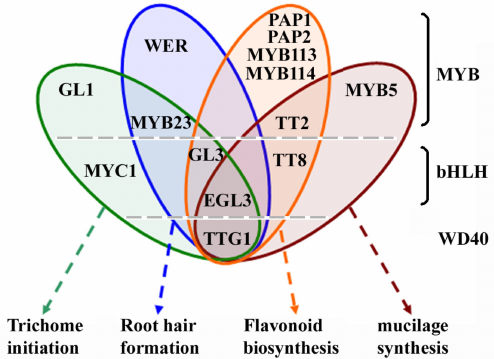
Figure 1. Components of the epidermal cell fate determination, flavonoid and mucilage biosynthesis regulating MBW activator complexes. Some of the components are presented in all the MBW activator complexes, some are not. The WD40-repeat protein TTG1, and the bHLH transcription factors EGL3 are involved in the regulation of epidermal cell fate determination, flavonoid and mucilage biosynthesis. The bHLH transcription factor MYC1 is involved in the regulation of trichome initiation. TT8 is involved in the regulation of flavonoid and mucilage biosynthesis. The MYB transcription factors involved in the regulation of epidermal cell fate determination, flavonoid and mucilage biosynthesis are largely di ff erent. WER is involved in the regulation of root hair formation. GL1 is involved in the regulation of trichome initiation, MYB5 is involved in the regulation of mucilage biosynthesis, and PAP1, PAP2, MYB113 and MYB114 are involved in the regulation of flavonoid biosynthesis. However, MYB23 is involved in the regulation of trichome initiation and root hair formation, whereas TT2 is involved in the regulation of flavonoid and mucilage